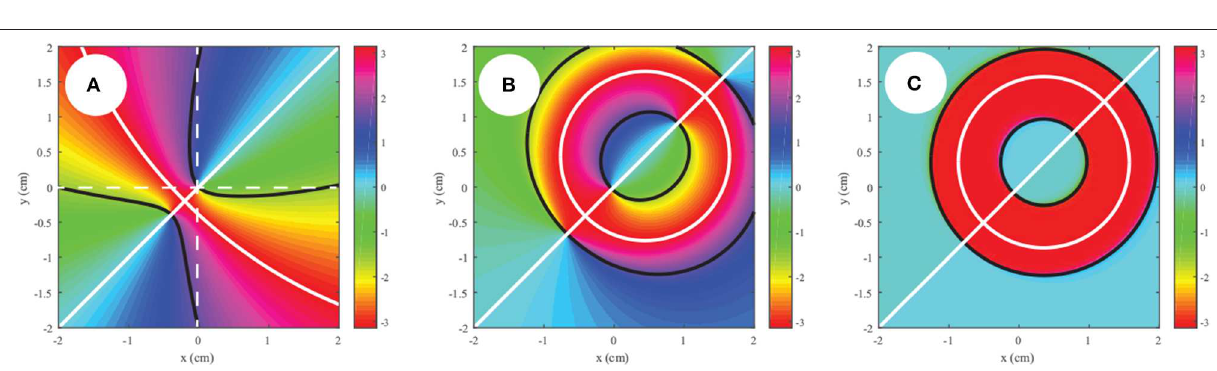
FIGURE 3 | Behavior of an eta singularity as the spatial coherence is decreased, with (A) δ observation point is taken at r 1